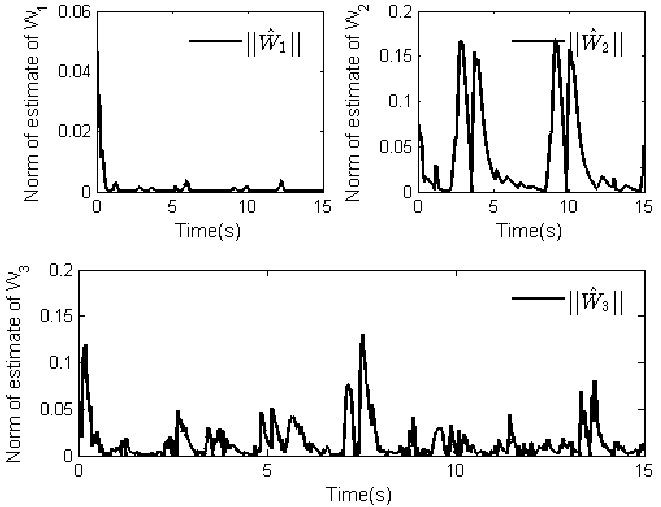
ˆ W (cid:107) , (cid:107) ˆ W (cid:107) and (cid:107) ˆ W ˆ W , ˆ W and 2 1 1 2